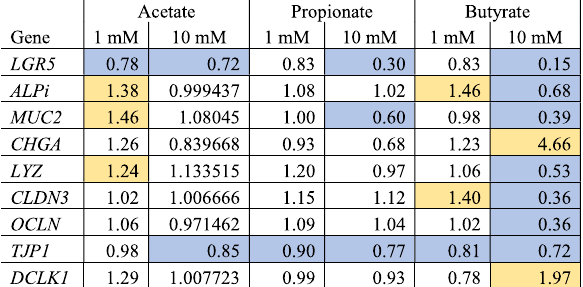
Table 2. Gene expression data of specific differentiation and cell type markers. Gene expression ratios in induced pluripotent stem cell derived intestinal epithelial cell layers exposed to 1 or 10 mM butyrate, propionate or acetate for 24 h compared with the control. Each ratio is based on the average expression data of 3 samples. Blue cells are significantly downregulated and yellow cells are significantly upregulated ( P < 0.05). The markers represent stem cells (LGR5), enterocytes (Alkaline Phosphatase intestinal; ALPi), goblet cells (Mucin 2; Muc2), enteroendocrine cells (chromogranin A; CHGA), paneth cells (Lysozyme; LYZ), tight junction